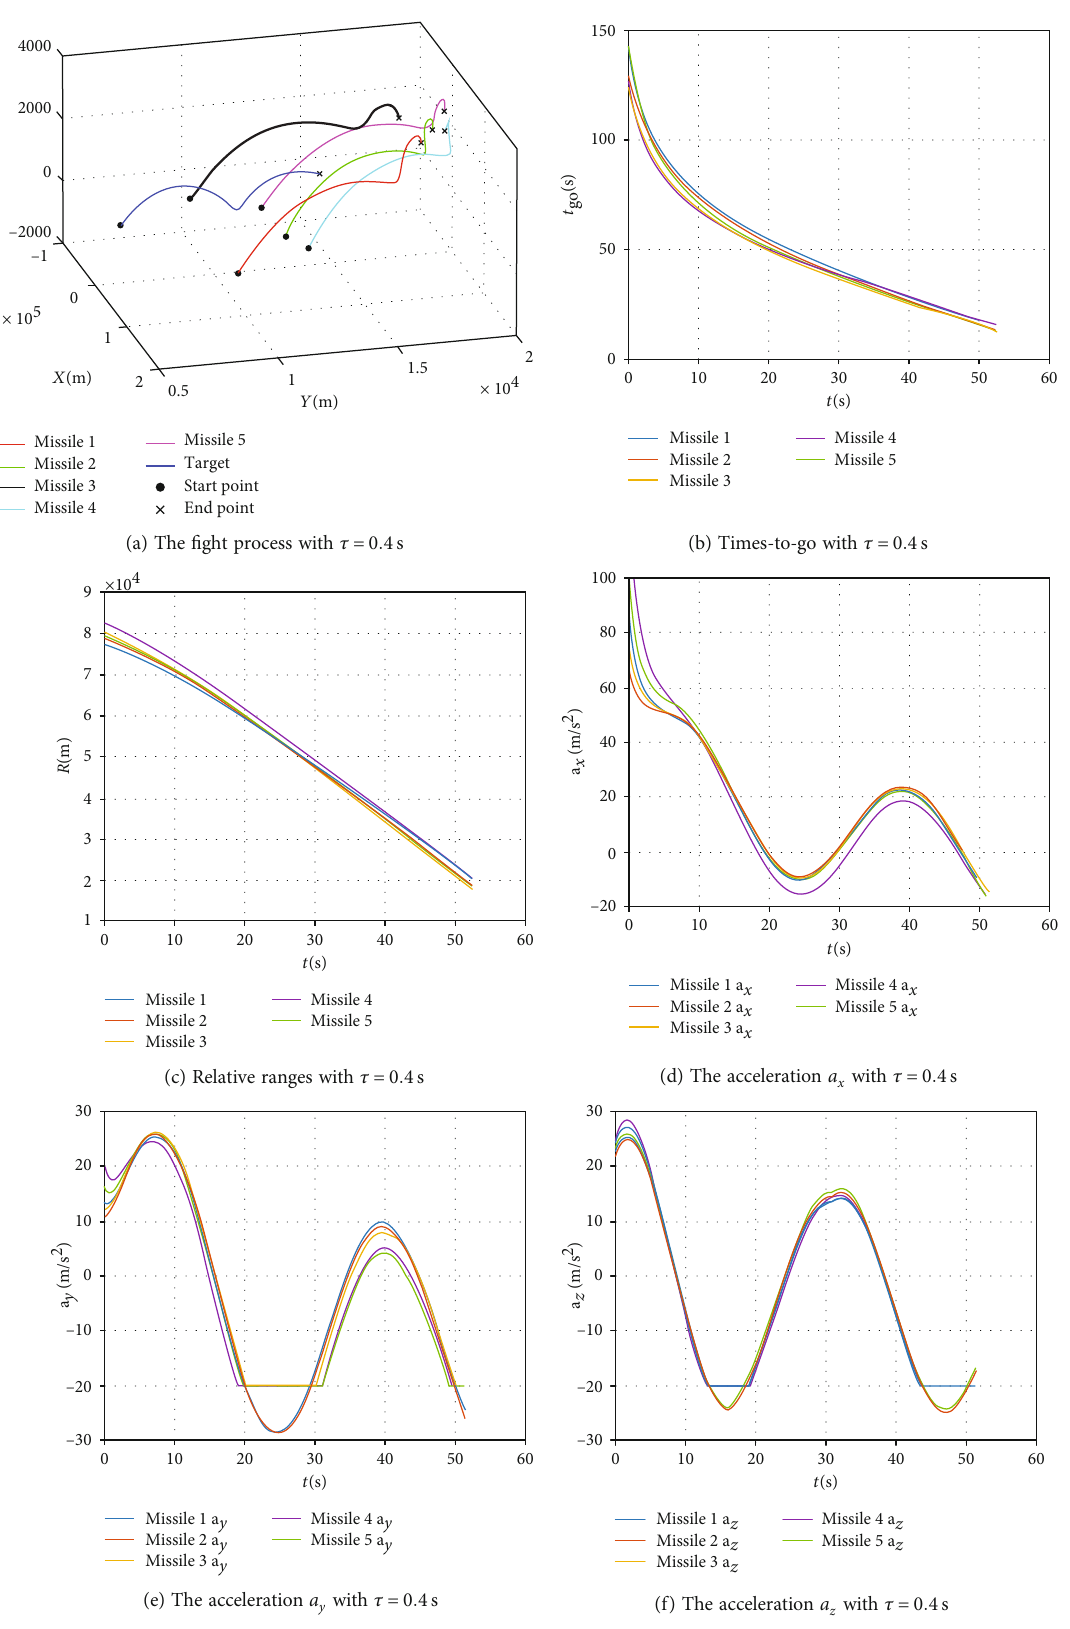
Figure 6: The simulation results with delay τ = 0 : 4s